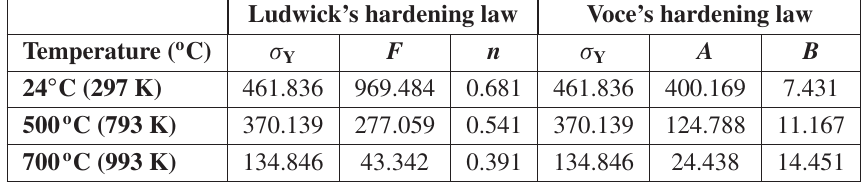
Table 2. Hardening parameters at elevated temperatures determined by fitting curves.